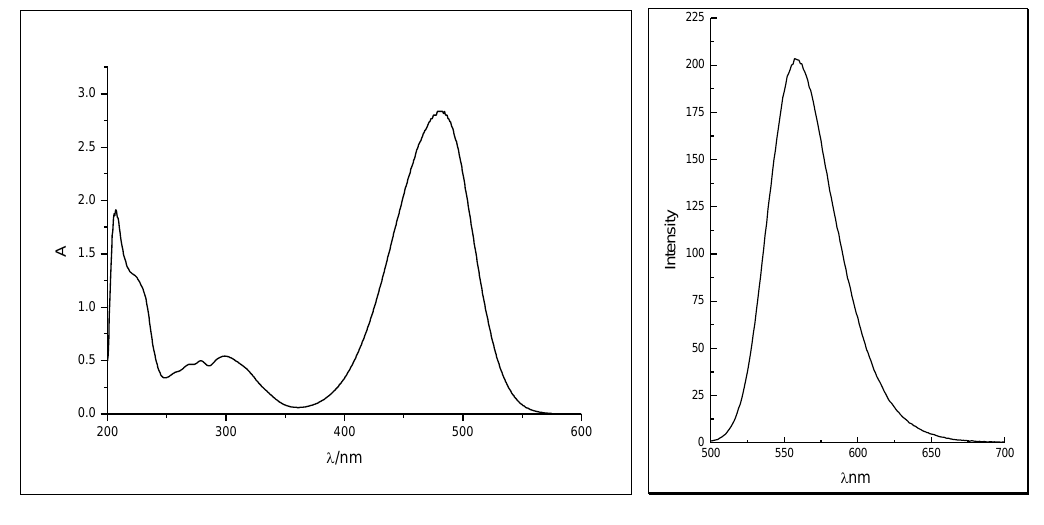
Figure 1. UV-Visible absorption (left) and emission spectrum (right) of the target